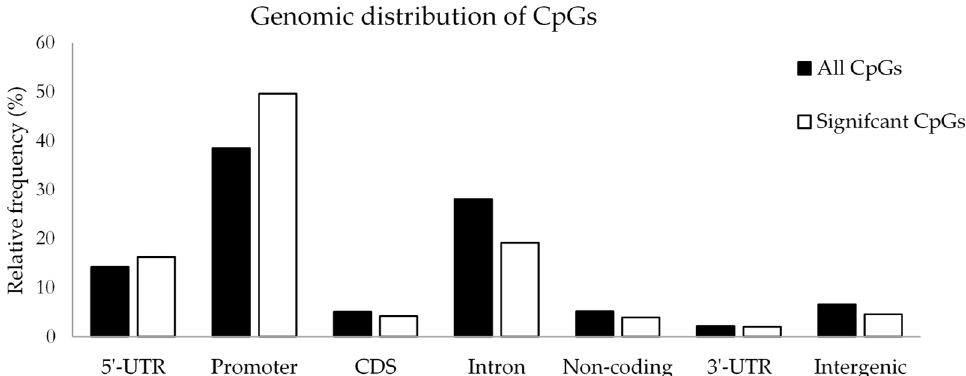
Figure 5. Relative frequency of all CpGs analysed (black bars) and differentially methylated CpGs identified in our study (white bars) in relation to genomic location across the genome. UTR: untranslated region; CDS: coding domain sequence.